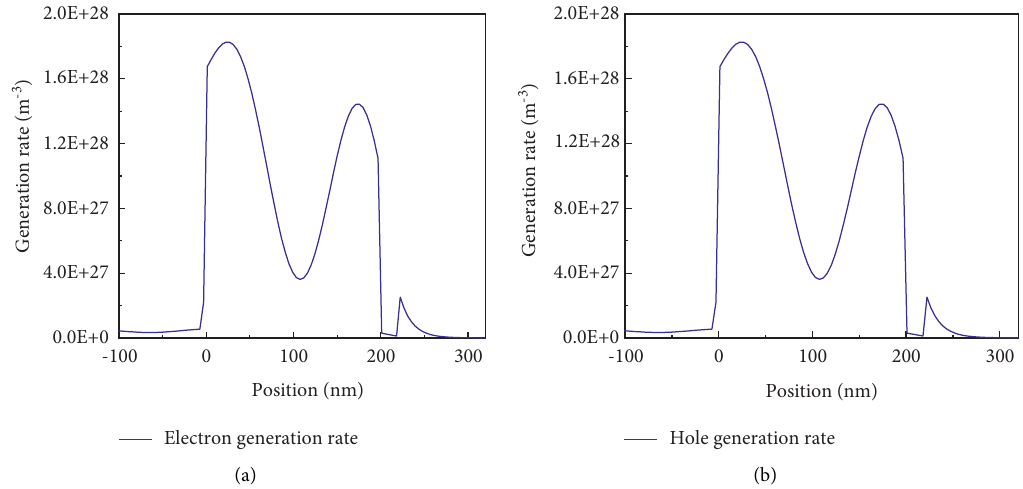
Figure 6: Generation rate of (a) electron and (b) hole for ITO/V2O5/PTB7:PC70BM/TiOx/Al device architecture.